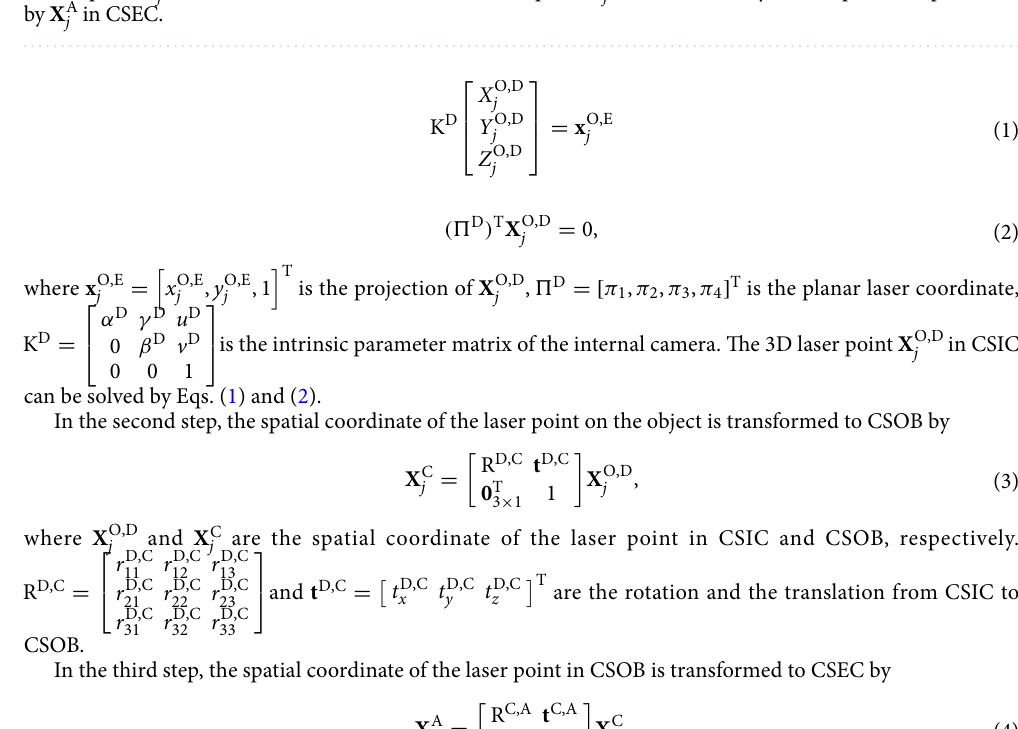
Figure 1. The principle of the vision reconstruction with the laser plane, internal camera, 3D reference and external camera in Ref. 21 . The planar laser intersects the measured object with the 3D point X O,D the 3D point X